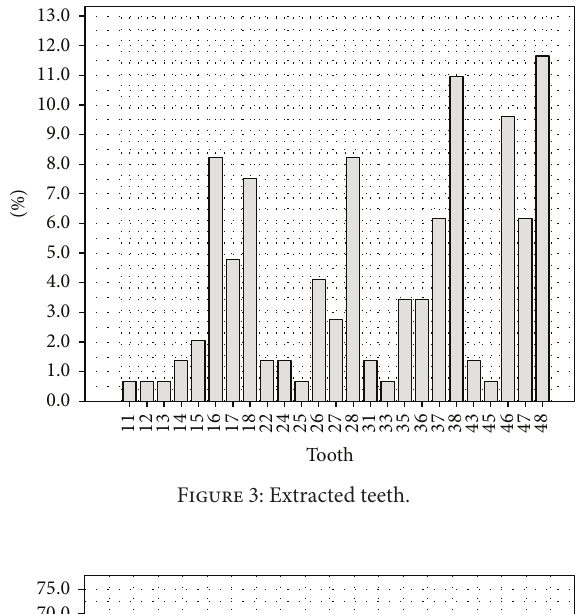
Figure 1: Gender distribution.